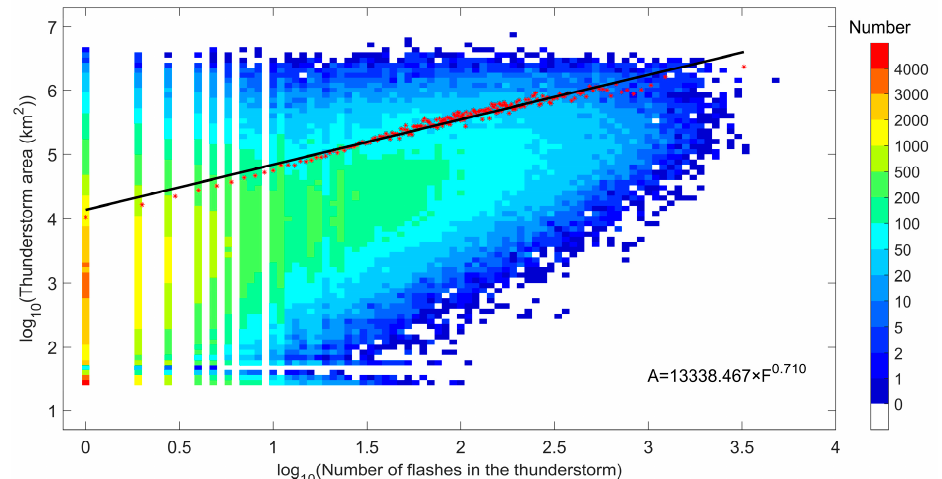
Figure 3. Sample distribution for different lightning numbers and thunderstorm cloud areas. The red “*” marks the calculated high-end thresholds for the abnormal cloud area corresponding to the groups sorted according to the WWLLN lightning number. The black line indicates the fit to the high-end thresholds, with the power-function equation shown at the bottom right.